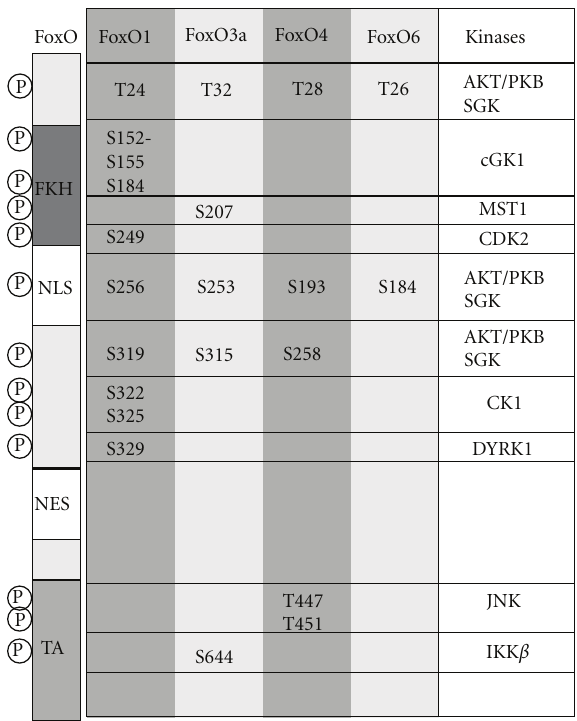
Figure 3: FoxO phosphorylation sites regulated via di ff erent kinases. Abbreviations: PKB, protein kinase B/Akt; SGK, serum- and glucocorticoid-induced protein kinase; cGK, cGMP-dependent protein kinase type 1; MST1, mammalian sterile 20-like 1 kinase; CDK 2, cyclin-dependent kinase 2; CK1, casein kinase 1; DYRK, dual specificity tyrosine-phosphorylation-regulated kinase; JNK, c- Jun N-terminal kinase; IKK, I κ B-kinase, NLS, nuclear localization signal; NES, nuclear export signal; FKH, forkhead domain; TA, transactivation